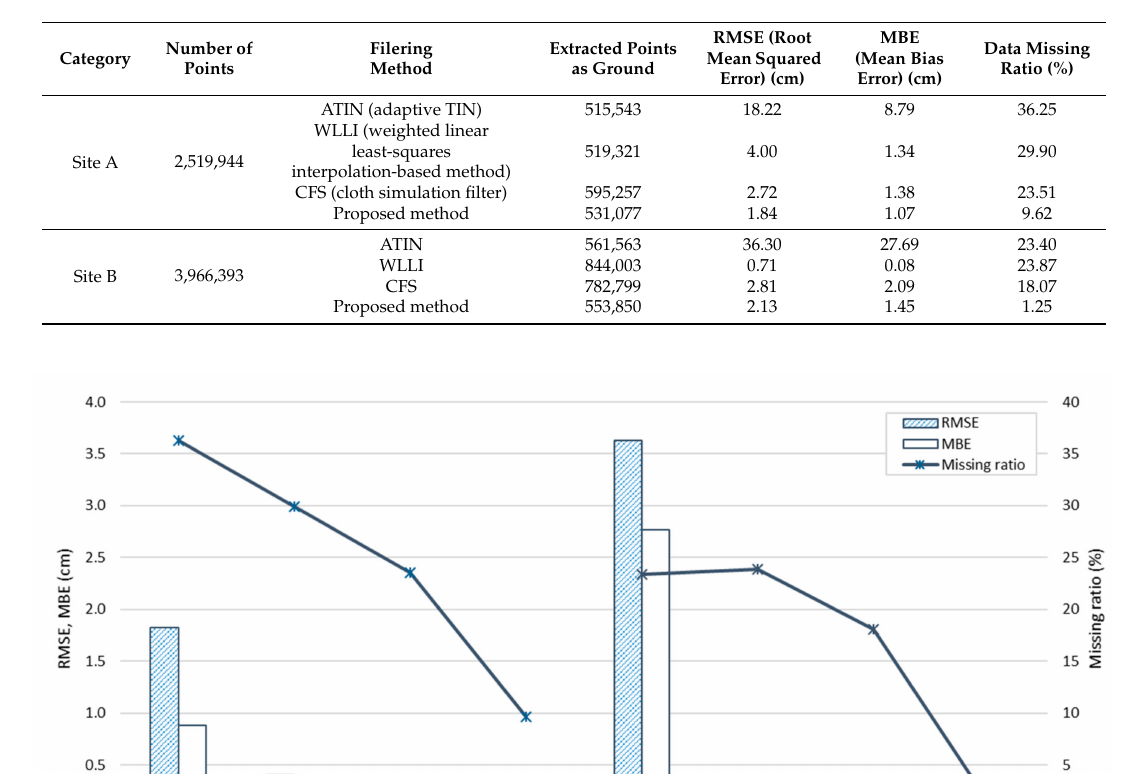
Table 2. Comparison of filtering results.